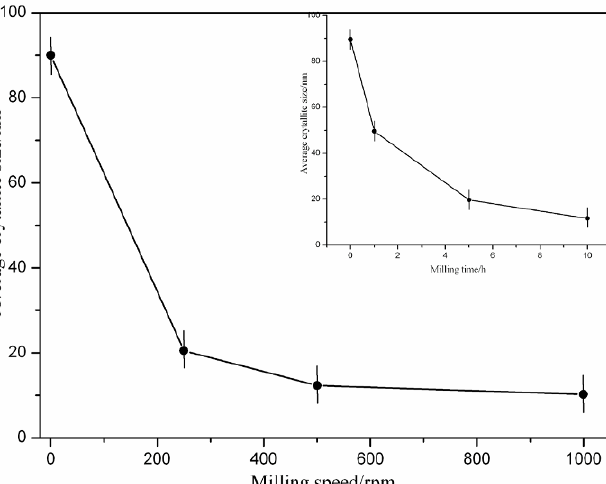
Figure 2. Average crystallite sizes of ZnO mechanically activated at different milling speed (250, 500 and 1000 rpm). Inside shows the average crystallite sizes of ZnO mechanically activated at 500 rpm at different milling time (0, 1, 5 and 10